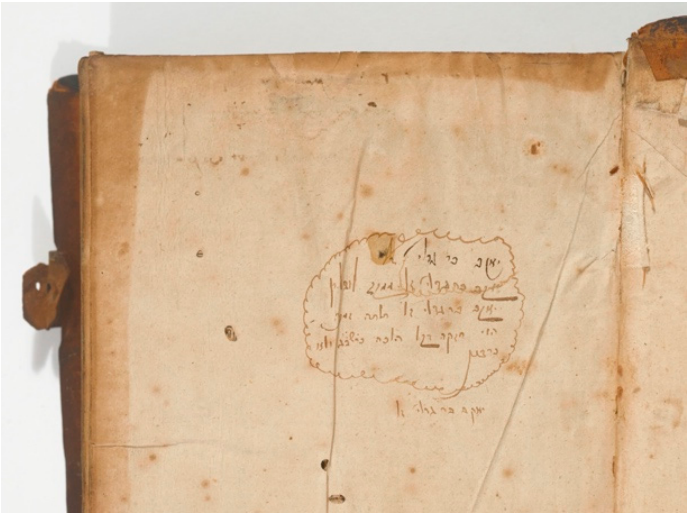
Figure 23. Inscription on Sefer HaMagid, Marsh’s Library C.3.1.19.